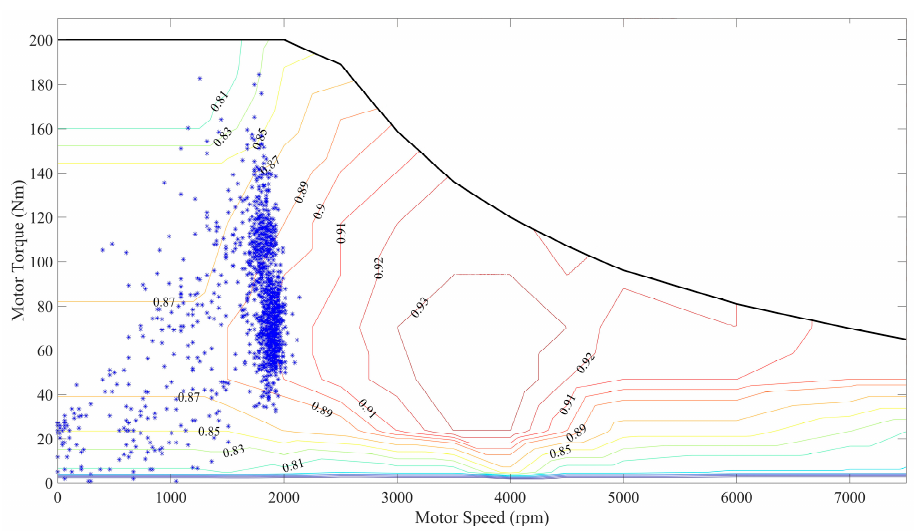
Figure 13. Working points of EM_T in SMPS.